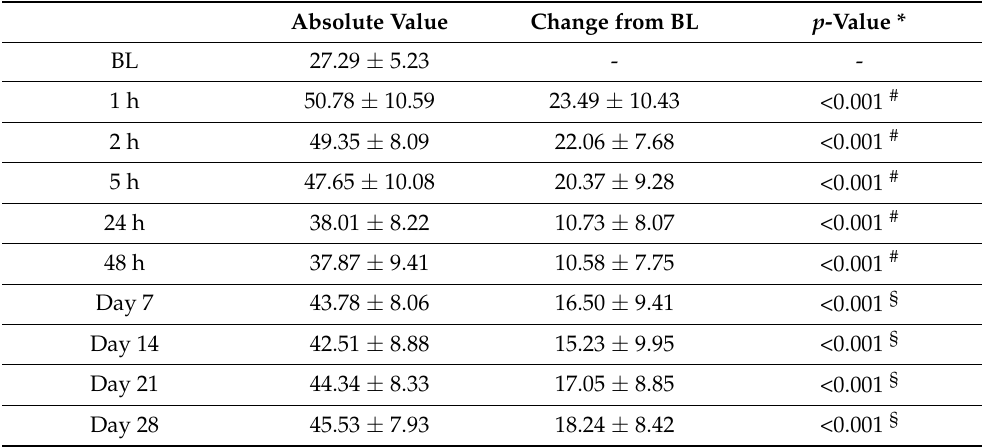
Table 4. Absolute skin capacitance measurement values and changes from baseline after single application of Emollient 2 (first 48 h) followed by once-daily application for 26